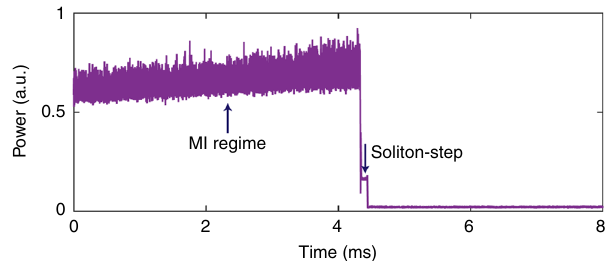
Fig. 5 Response of comb power when laser is swept through the AlGaAs resonance. The step-like trace indicates a transition to the soliton